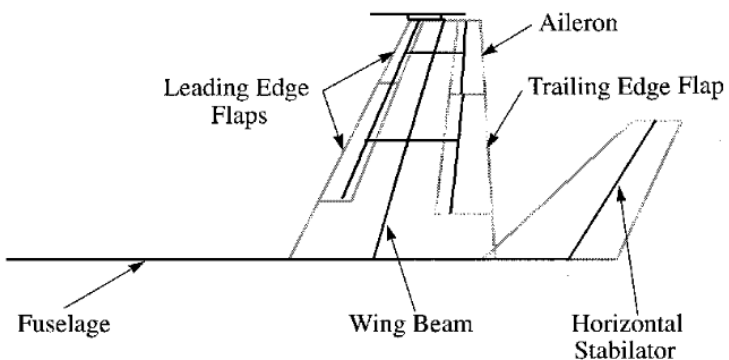
Figure 6. Aerodynamic model of aircraft, Adapt with permission from [28].